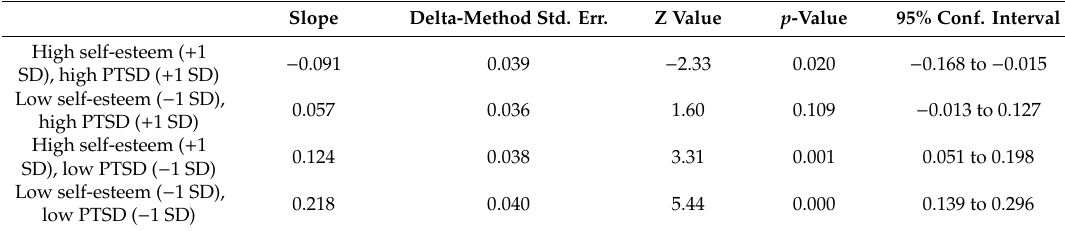
Table 3. Slope difference test of three-way interactions.